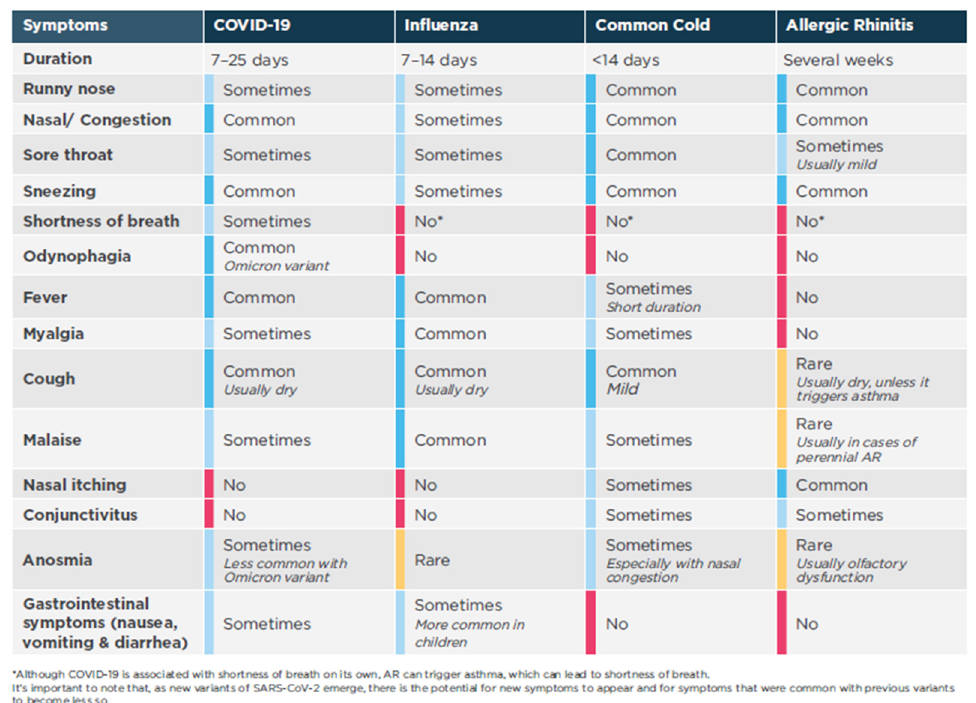
Figure 1. Identification and differentiation of common upper respiratory conditions.